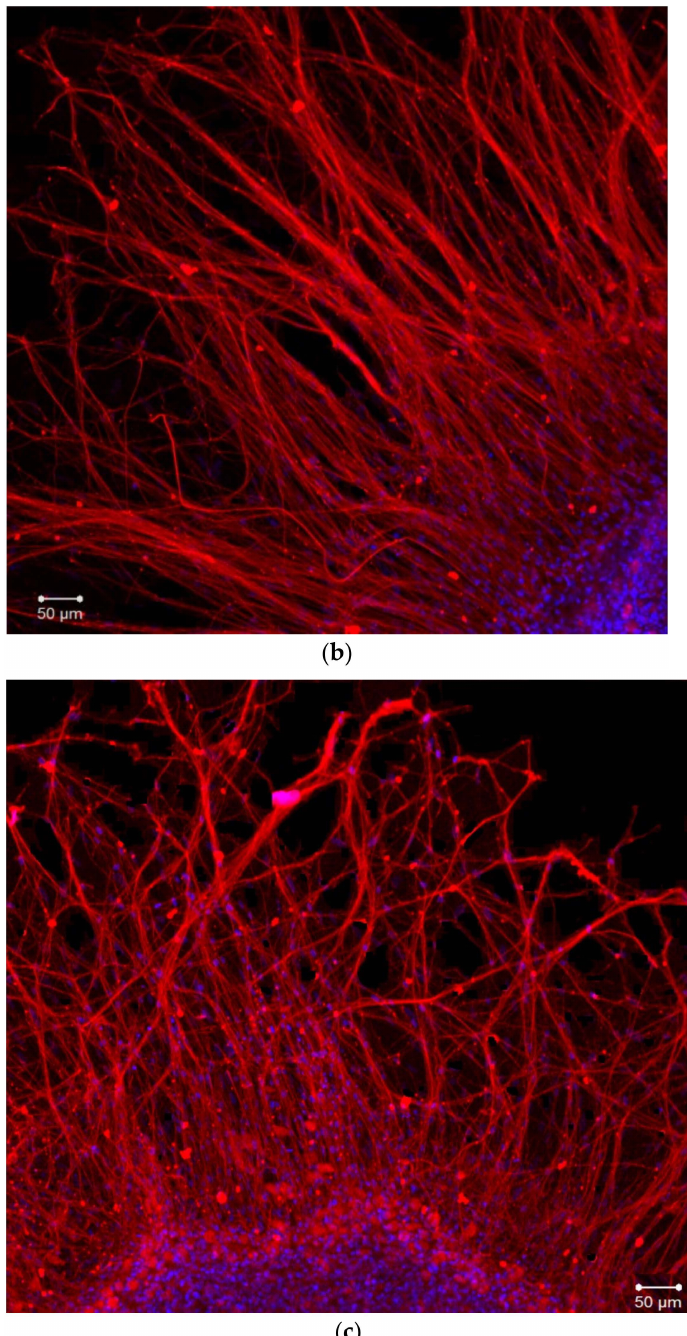
Figure 4. Fragments of DRG explant growth zone (third day of culturing). DRG explants were immunostained with anti-neurofilament 200 antibody (red). Nuclei were counterstained with DAPI (blue). Scale bar 50 µ m. ( a )—control, ( b )—TP1 (100 nM), ( c )—TP2 (100